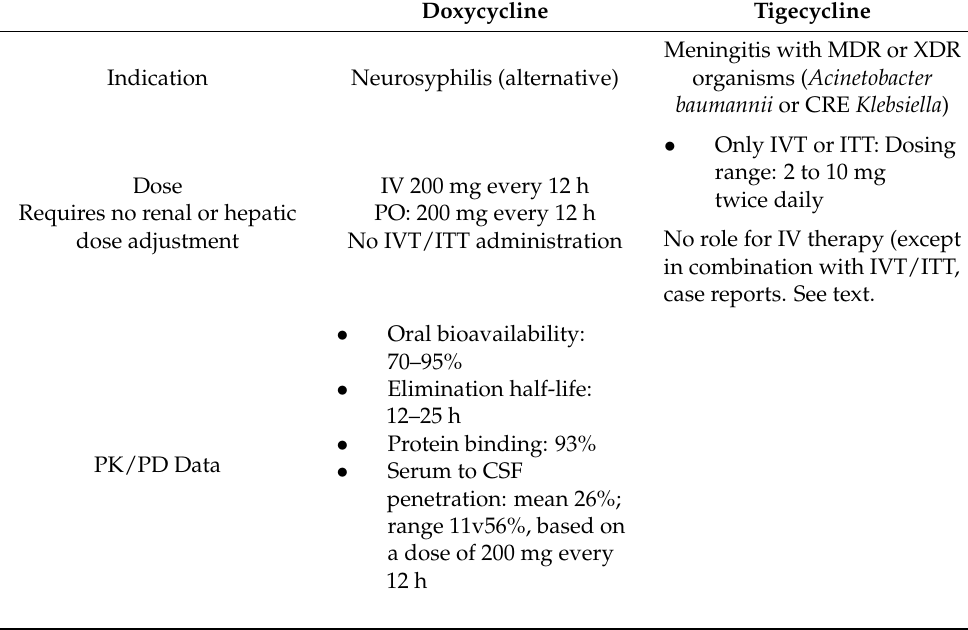
Table 8. Tetracyclines indications, dosing, and PK/PD